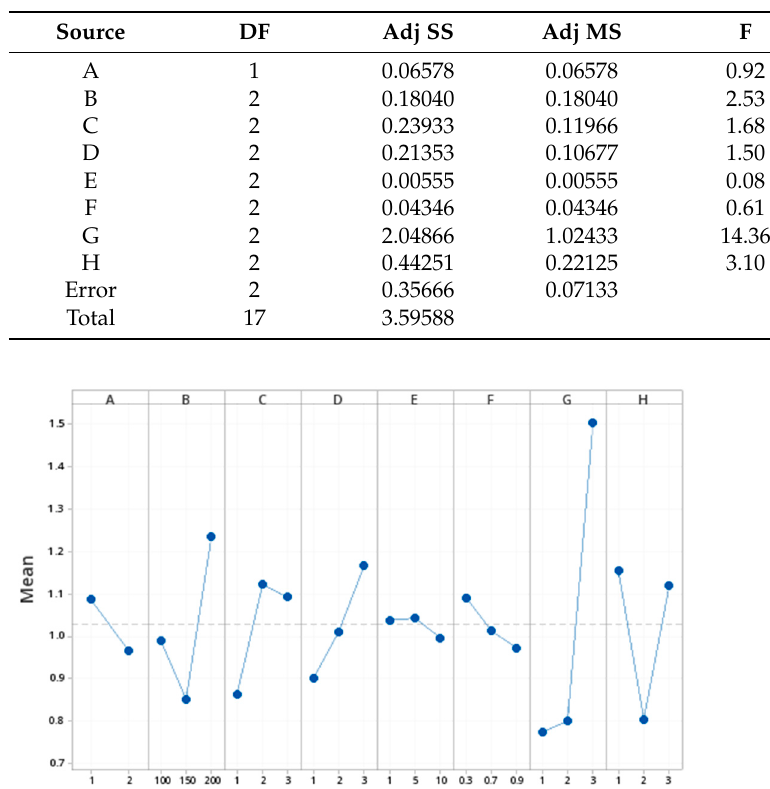
Table 4. ANOVA analysis.